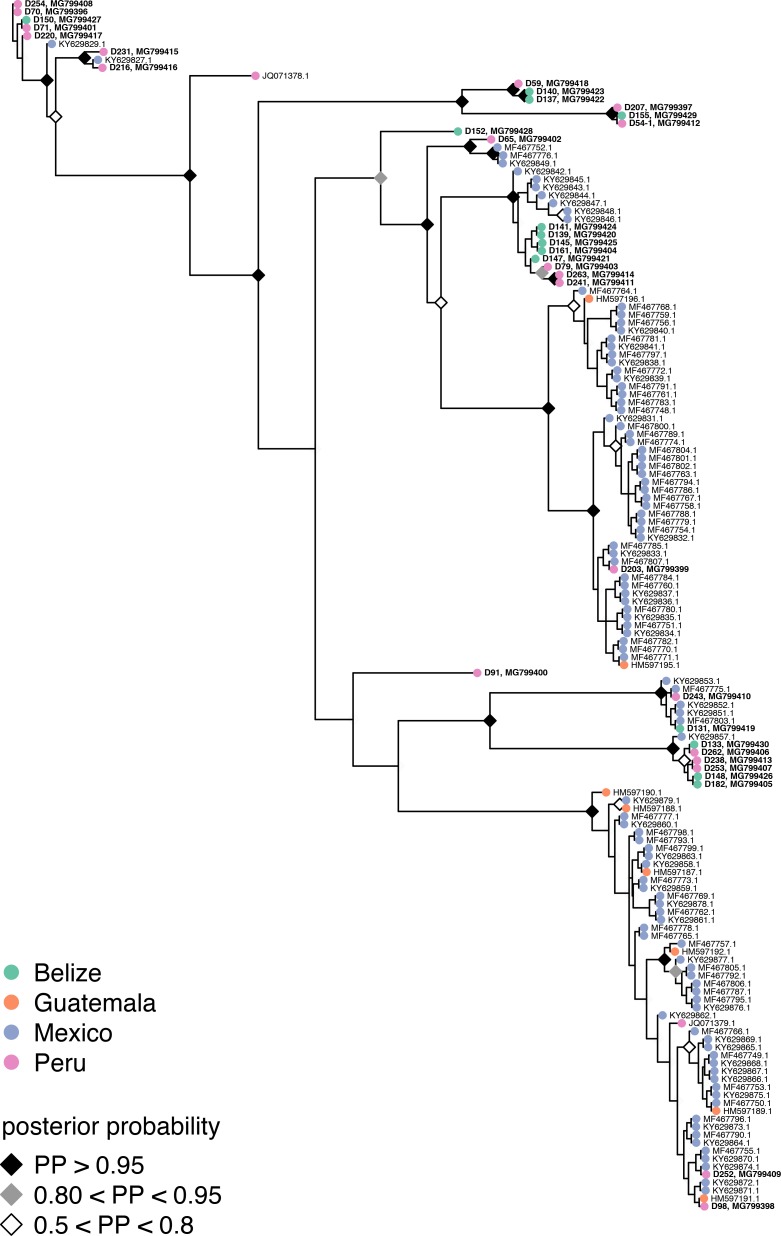
Phylogenetic relationships for the gltA gene among the sample of Bartonella genotypes detected in vampire bats from this study and vampire bat Bartonella genotypes from GenBank.All sequences are displayed with their GenBank accession numbers, and sequences from this study are listed in bold with bat ID numbers. The tips of all sequences are colored by geography, and diamonds depict posterior probabilities of nodes greater than 50%.